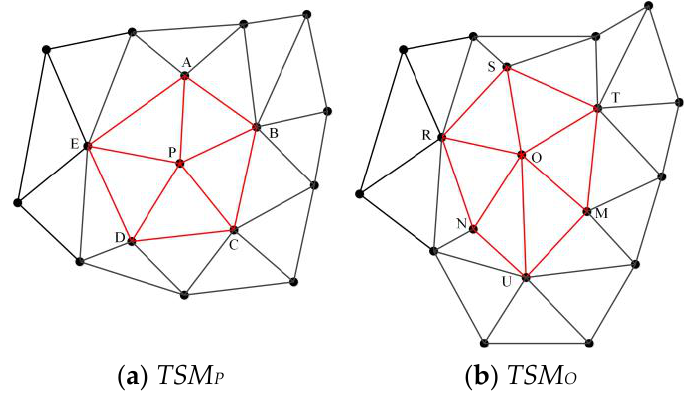
Figure 7. Triangular mesh structure of ( a ) TSM P and ( b ) TSM O .